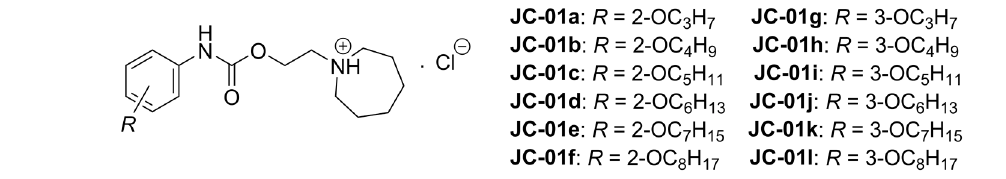
Figure 3. Chemical structure of the compounds JC-01a – l , effective local anesthetics [33], which were able to decrease surface tension of water [34].